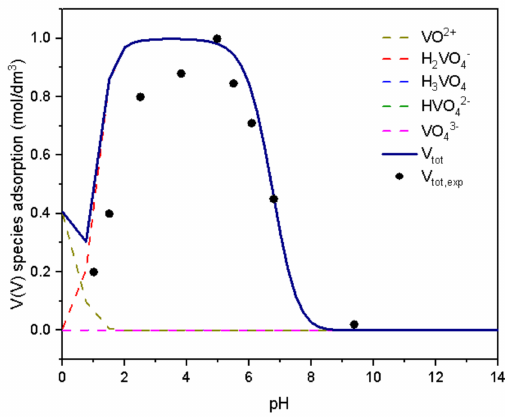
Figure 7. Effect of pH on V(V) sorption from aqueous solutions onto m-Si-poly(GME)-det. Blue, green and magenta dashed lines represent all zero